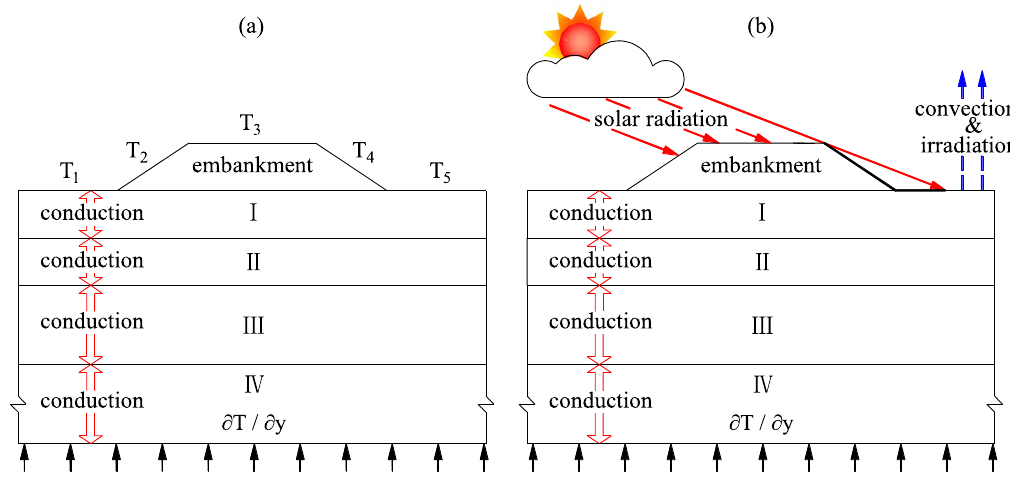
Figure 1. The computational domain of an embankment underlain by permafrost. ( a ) temperature-controlled upper boundary, ( b ) heat-flux upper boundary. T i ( i = 1, 2, …, 5) stands for a specific sinusoidal temperature